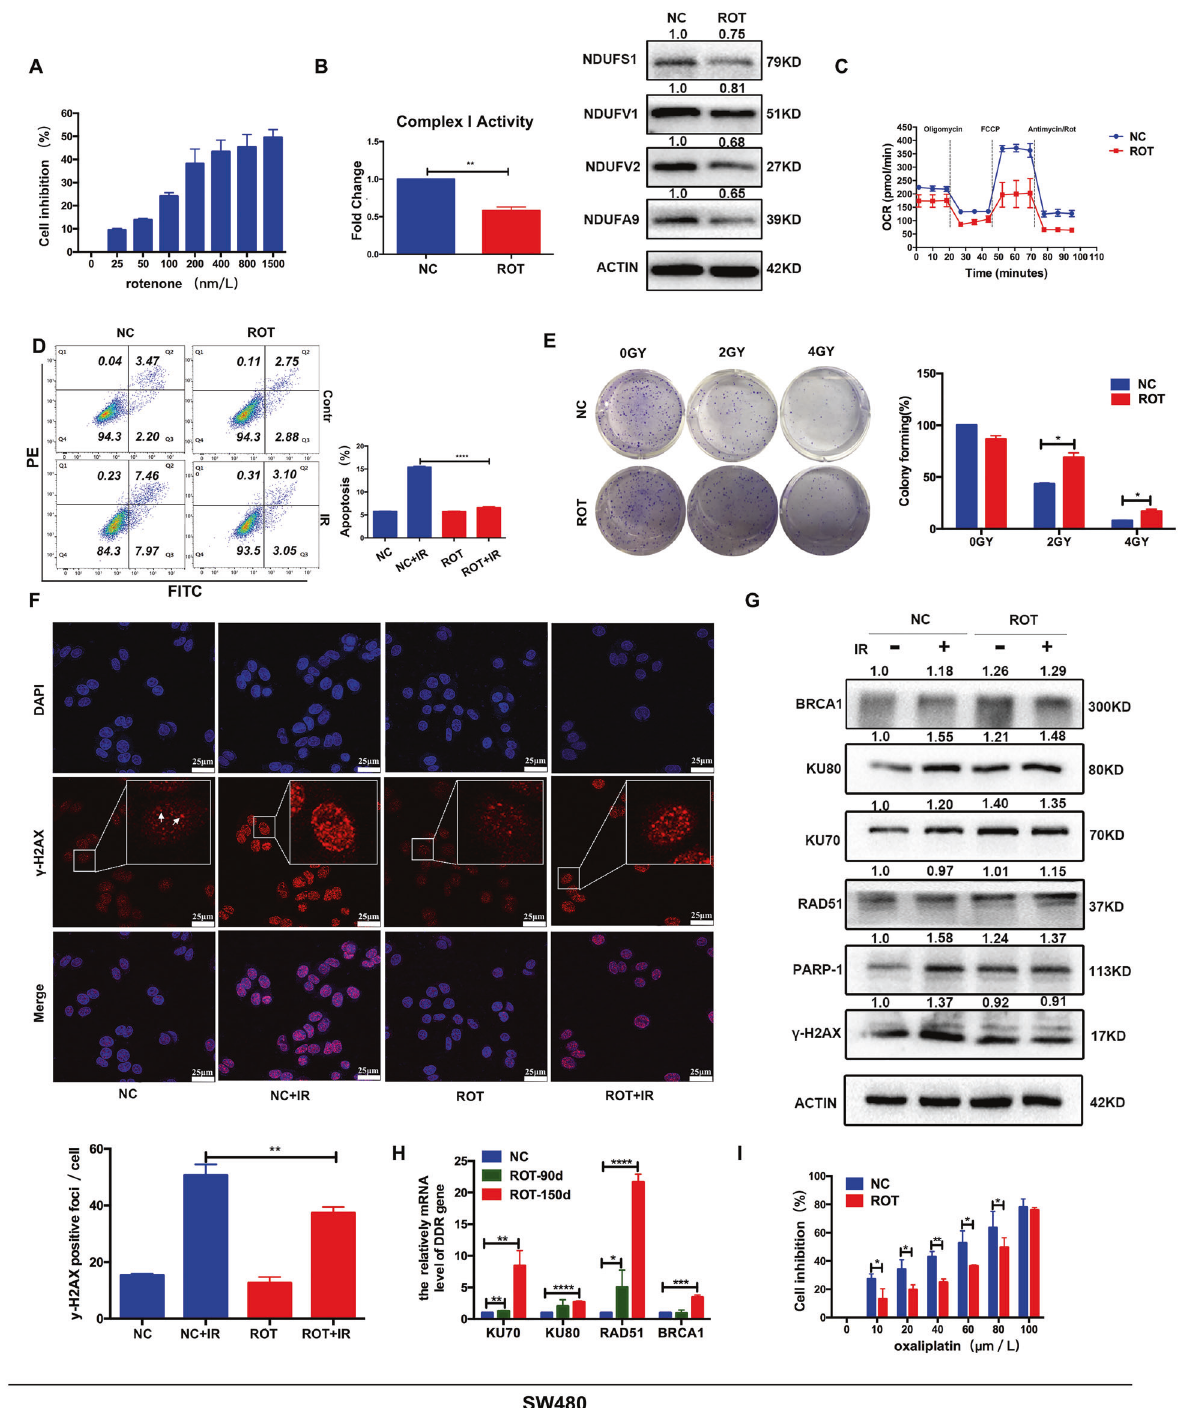
Fig. 2 Complex I de fi cient cells exhibited radioresistance and enhanced DNA damage repair. A Cell inhibition rate of SW480 cells treated with various concentrations of rotenone for 24 h. B Relative mitochondrial complex I activity and complex I protein in NC and ROT cells. The band intensity was quanti fi ed with Image lab software (Bio-Rad) and normalized to Actin. ( n = 3), ** P < 0.01. C Oxygen consumption rate (OCR) was measured in NC and ROT cells. D Apoptosis was quanti fi ed by combined staining of annexin V and PI, and fl uorescence was analyzed using fl ow cytometry. ( n = 3), **** P < 0.0001. E Clonogenic potential with 0 Gy, 2 Gy, 4 Gy irradiation and statistical analysis. ( n = 4), * P < 0.05. F After 4 Gy X-ray irradiation, confocal microscopy was used to visualize the intracellular γ -H2AX foci (red) and DAPI (blue) in NC and ROT cells. Inset shows magni fi ed areas, and the white arrow indicates foci. Scale bar: 25 μ m. Foci per cell was calculated, ( n = 6), ** P < 0.01. G The DNA damage repair protein in NC and ROT cells with or without 4 Gy X-ray irradiation. H mRNA levels of DDR genes in NC and ROT cells at different periods (70 days and 150 days) were analyzed by real-time PCR. ( n = 5), ** P < 0.01, *** P < 0.001, **** P < 0.0001. I Cell inhibition rate of different concentrations of oxaliplatin on NC and ROT cells for 24 h ( n = 5), * P < 0.05, ** P < 0.01. Data are presented as the means ± s.e.m.